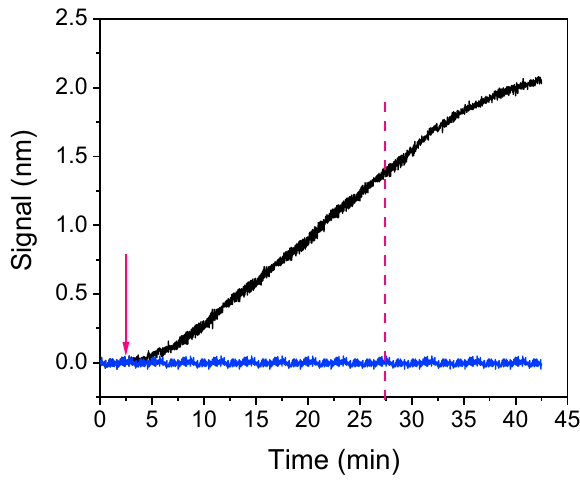
Figure 4. Real-time signal evolution upon passing over a chip coated with a 200 µ g/mL Salmonella LPS solution zero calibrator consisting of a 3 µ g/mL anti- Salmonella antibody solution mixed with assay buffer at a 1:1 volume ratio for 40 min (black line). For the assessment of non-specific binding, the zero calibrator signal obtained from a chip coated with bovine serum albumin (BSA) is indicated (blue line). The arrow indicates the time point of anti- Salmonella antibody solution introduction and the vertical, magenta dotted line the time point corresponding to 25 min after the introduction of the antibody solution.